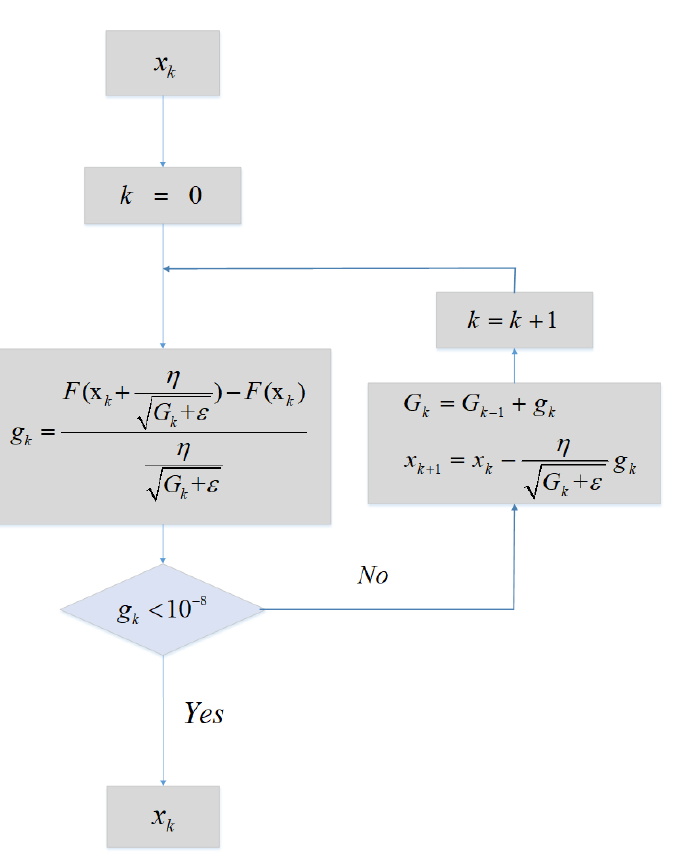
Figure 1. Flowchart of